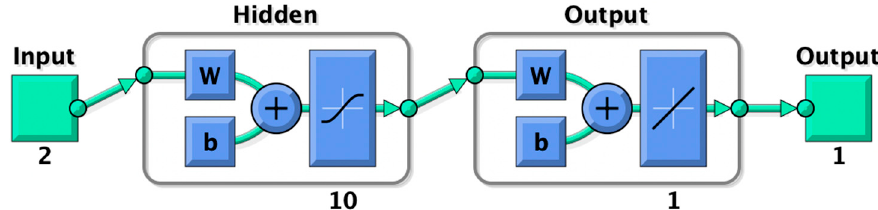
Figure 1. Diagram of the two-layer feedforward ANNs with a tan-sigmoid function in the hidden layer and a linear transfer function in the output layer. Ten neurons were used for amyl alcohol, ethyl acetate and n-propanol and five for isobutanol.